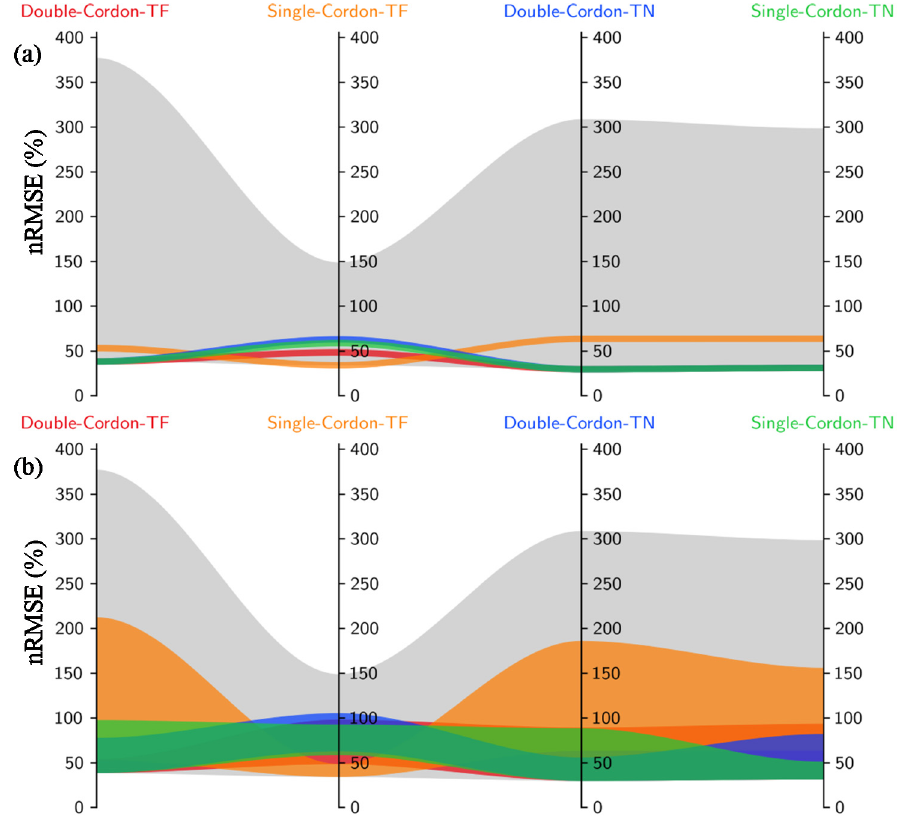
Figure 5. Parallel coordinate plot for the overall distribution of prediction uncertainties (nRMSE, %) based on all tested parameter vectors (684,375) over the combined variable (i.e., objective function). For each variety–training system (with a specific color), ( a ) the best-performing parameter vector and ( b ) the top 5% (percentile) best-performing vectors are presented. The background grey shade represents the range of results over all the parameter vectors.